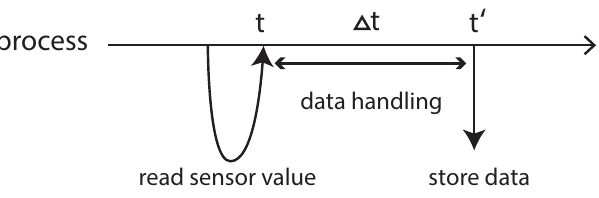
Figure 2. Timestamps in a